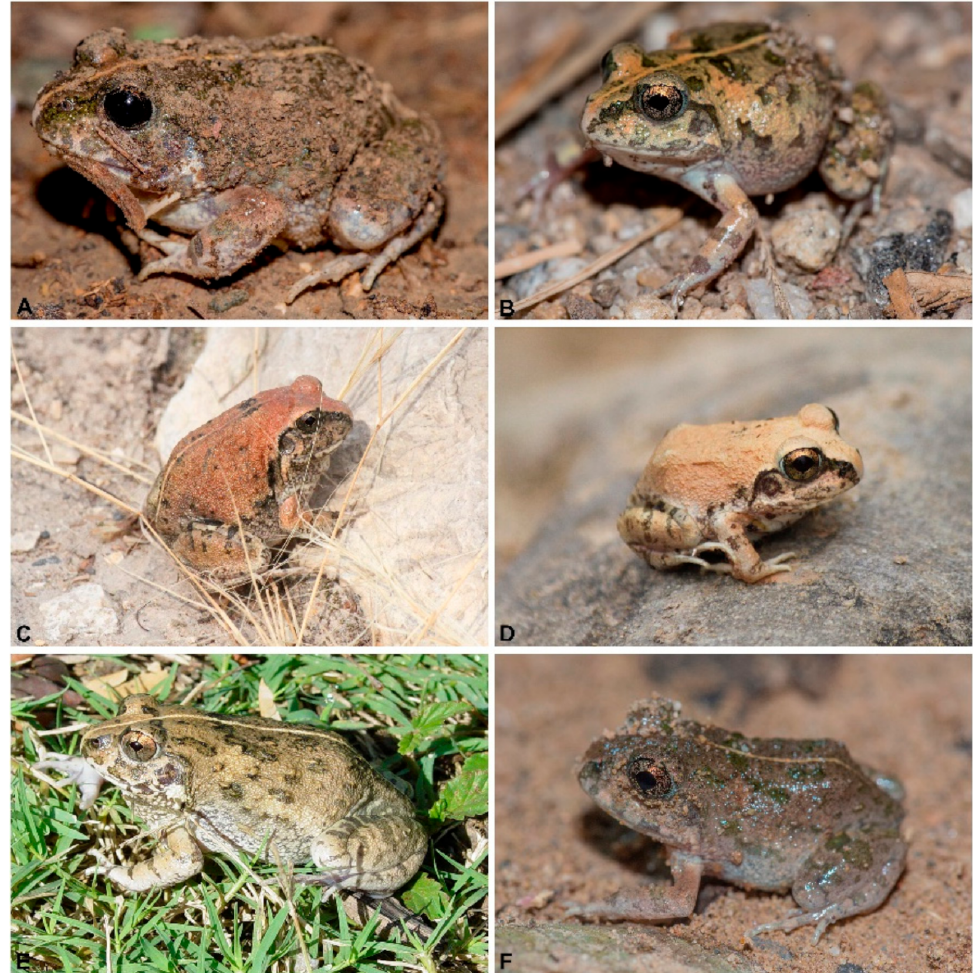
Figure 1. The external morphological color variation of Sphaerotheca maskeyi from Pakistan: ( A ) Shah Alam Baba (adult; DJ 9471 used in this study); ( B ) Batai Kalay, Qadir Nagar River, Buner (subadult); ( C ) Parera, Chakwal; ( D ) Kotli, Azad and Jammu Kashmir (subadult); ( E ) Shakarparian, Islamabad (adult); ( F ) Margalla Hills National Park